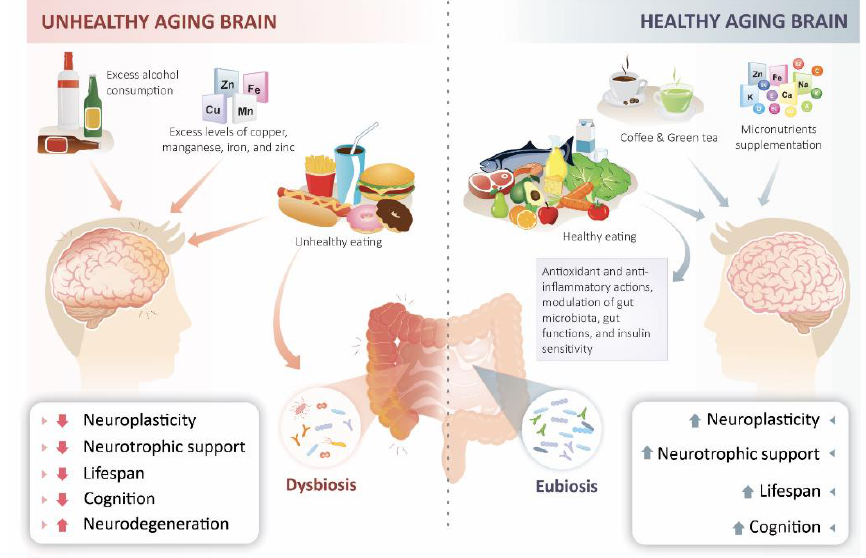
Figure 3. The contribution of diets to brain health during aging. Source: Author’s own work.